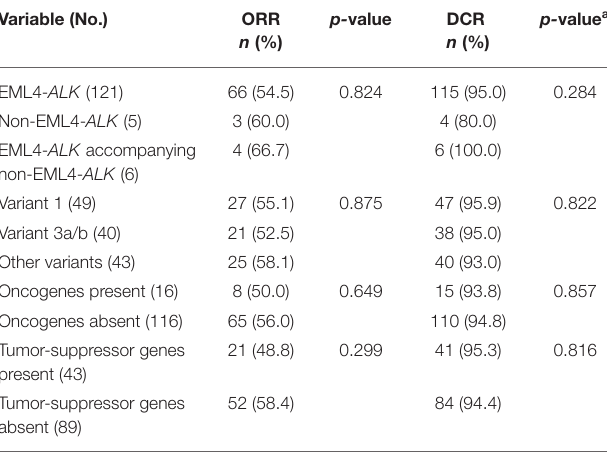
TABLE 2 | Clinical responses according to ALK variants and concomitant mutations detected. Variable